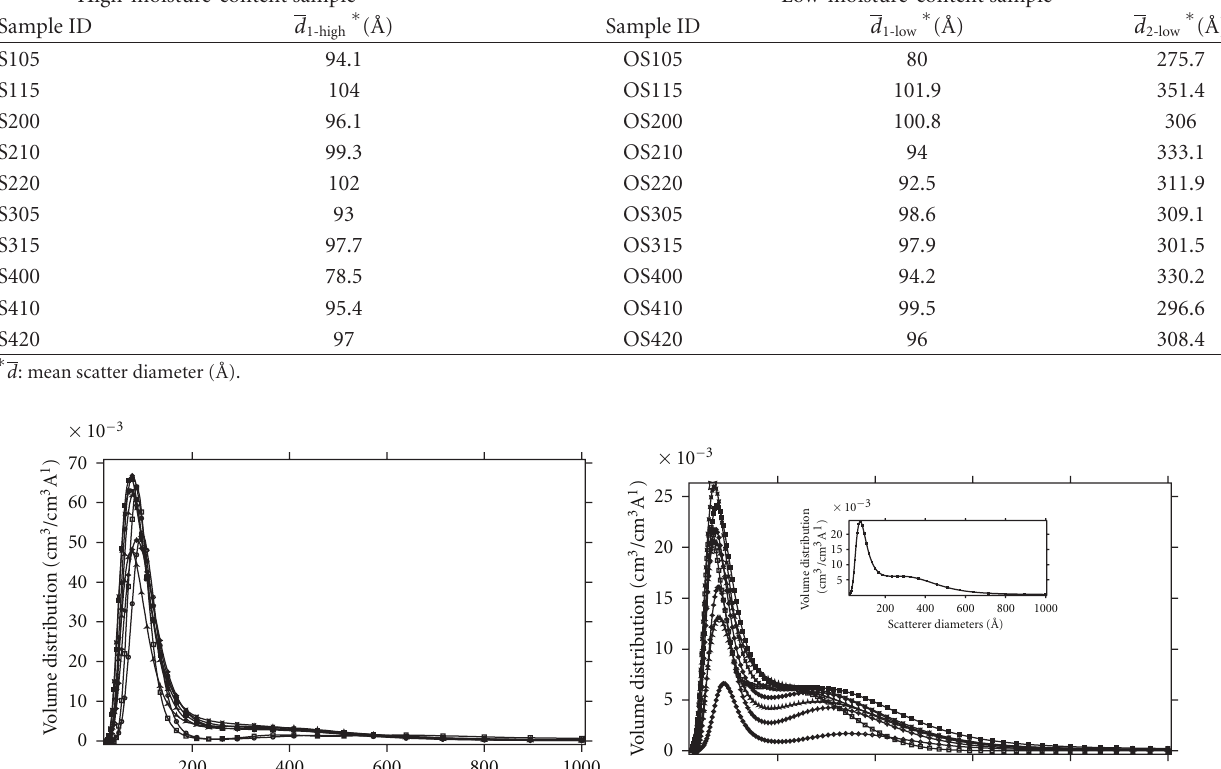
Table 2: Radius ( ˚A) from size distribution calculated by MEM method for both the high- and low-moisture-content samples. High-moisture-content sample